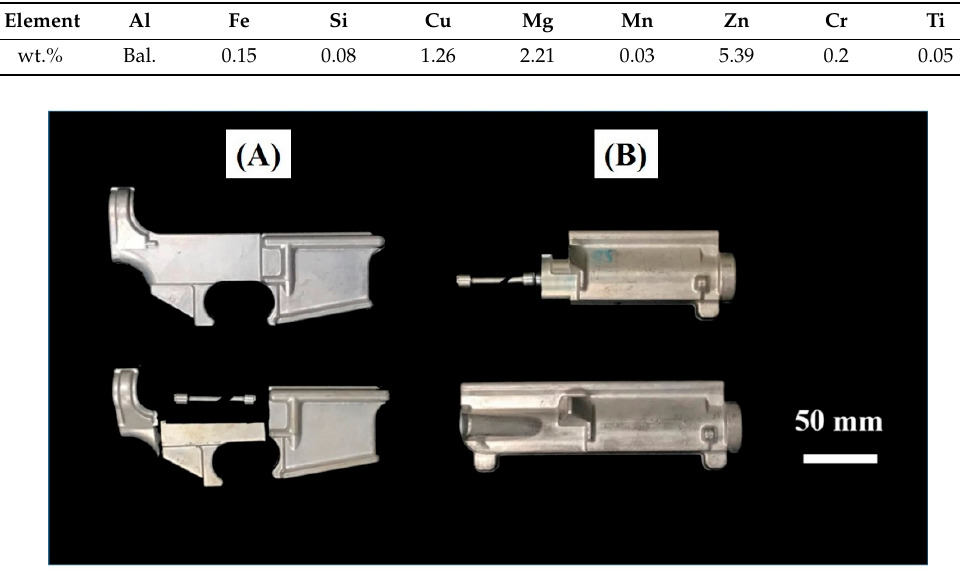
Figure 1. Photographs of 7075 aluminum hot forging parts.